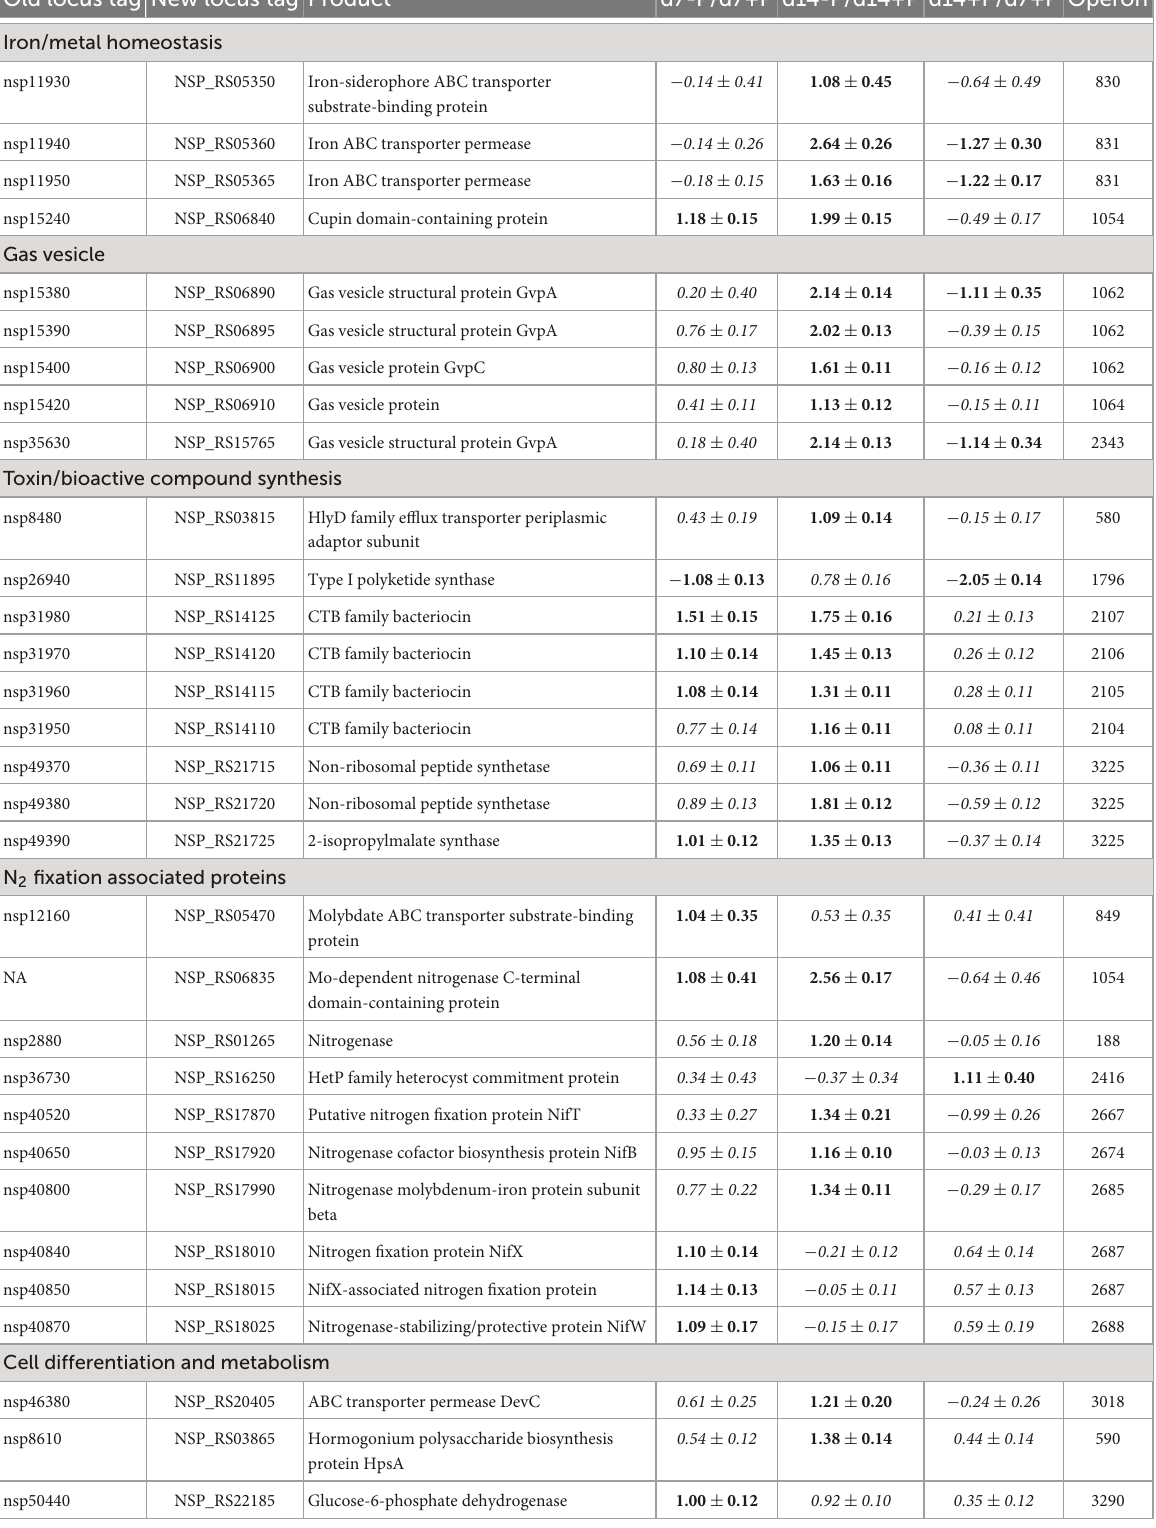
TABLE 2 Expression changes of genes encoding proteins indirectly involved in P acclimation of N. spumigena CCY9414 after 7 or 14 days of P-limitation as well as during growth for 14 days in P-replete medium. Old locus tag New locus tag